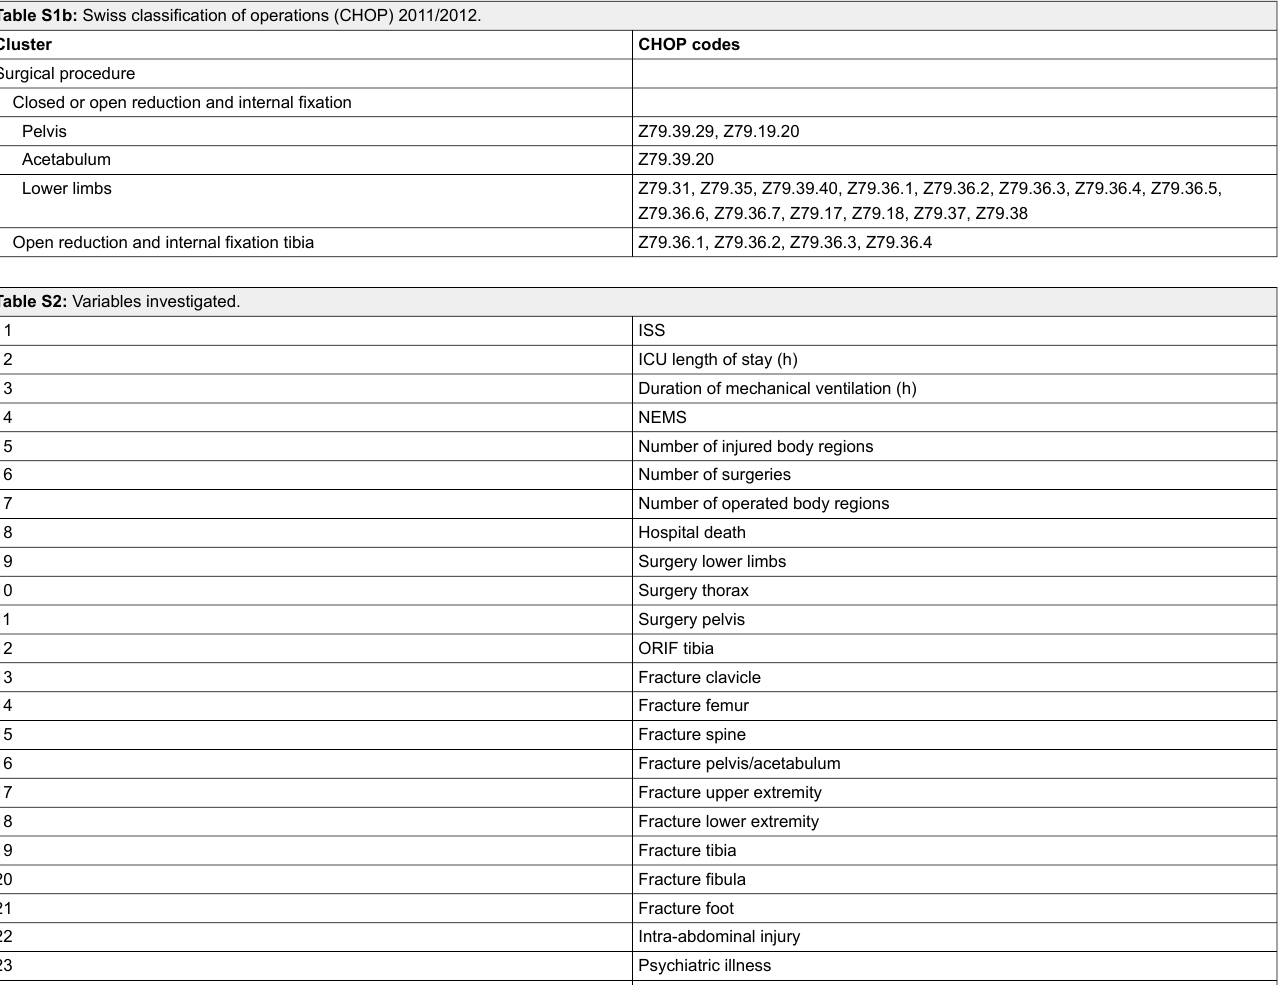
Table S1b: Swiss classification of operations (CHOP) 2011/2012. Cluster